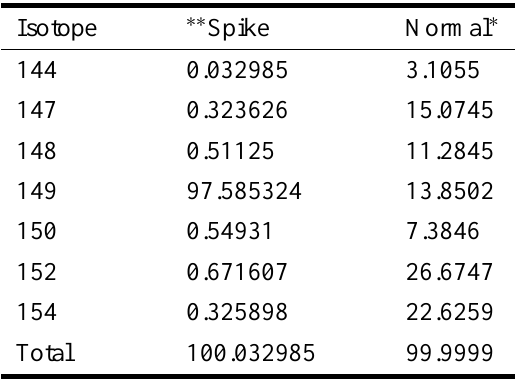
Isotopic Abundance for Sm ( % )